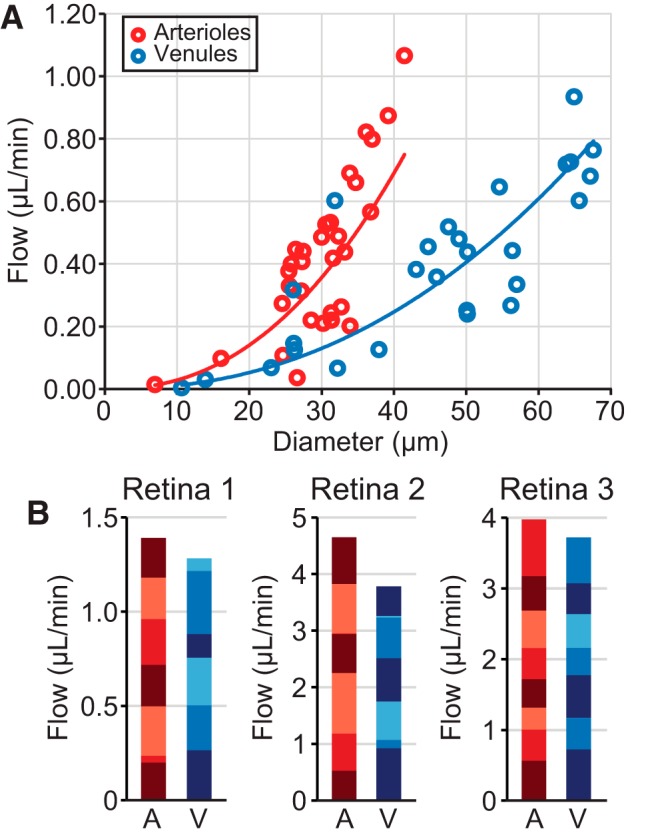
Total retinal blood flow. A, Blood flow in individual primary arterioles (red) and venules (blue) emerging from the optic disk, plotted against vessel diameter and fit with power functions (see text for details). B, Total blood flow in three retinas. Left columns represent arterioles (A), and right columns represent venules (V). Each color block indicates the flow in an individual vessel. The full bar height is the sum of all individual flows, corresponding to the total blood flow in arterioles or venules in a retina.